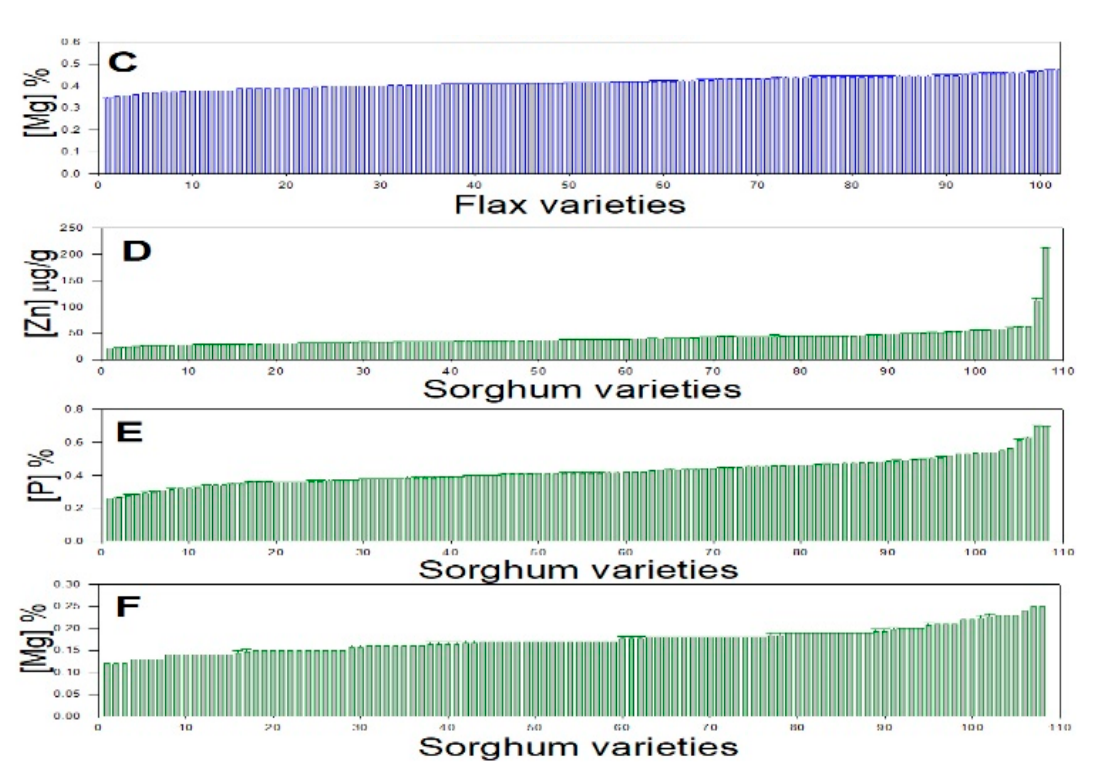
Figure 2. Average concentration of three replicates: ( A ) Flax Zn; ( B ) flax P; ( C ) flax Mg; ( D ) sorghum Zn; ( E ) sorghum P; and ( F ) sorghum Mg. (see Table 1 for all others). Table 1. Mean elemental concentrations of 102 flax varieties as % (N, P, K, Mg, Ca, and S) and µ g/g (Zn, Mn, Fe, Cu, and Mo) obtained from ICP-MS.